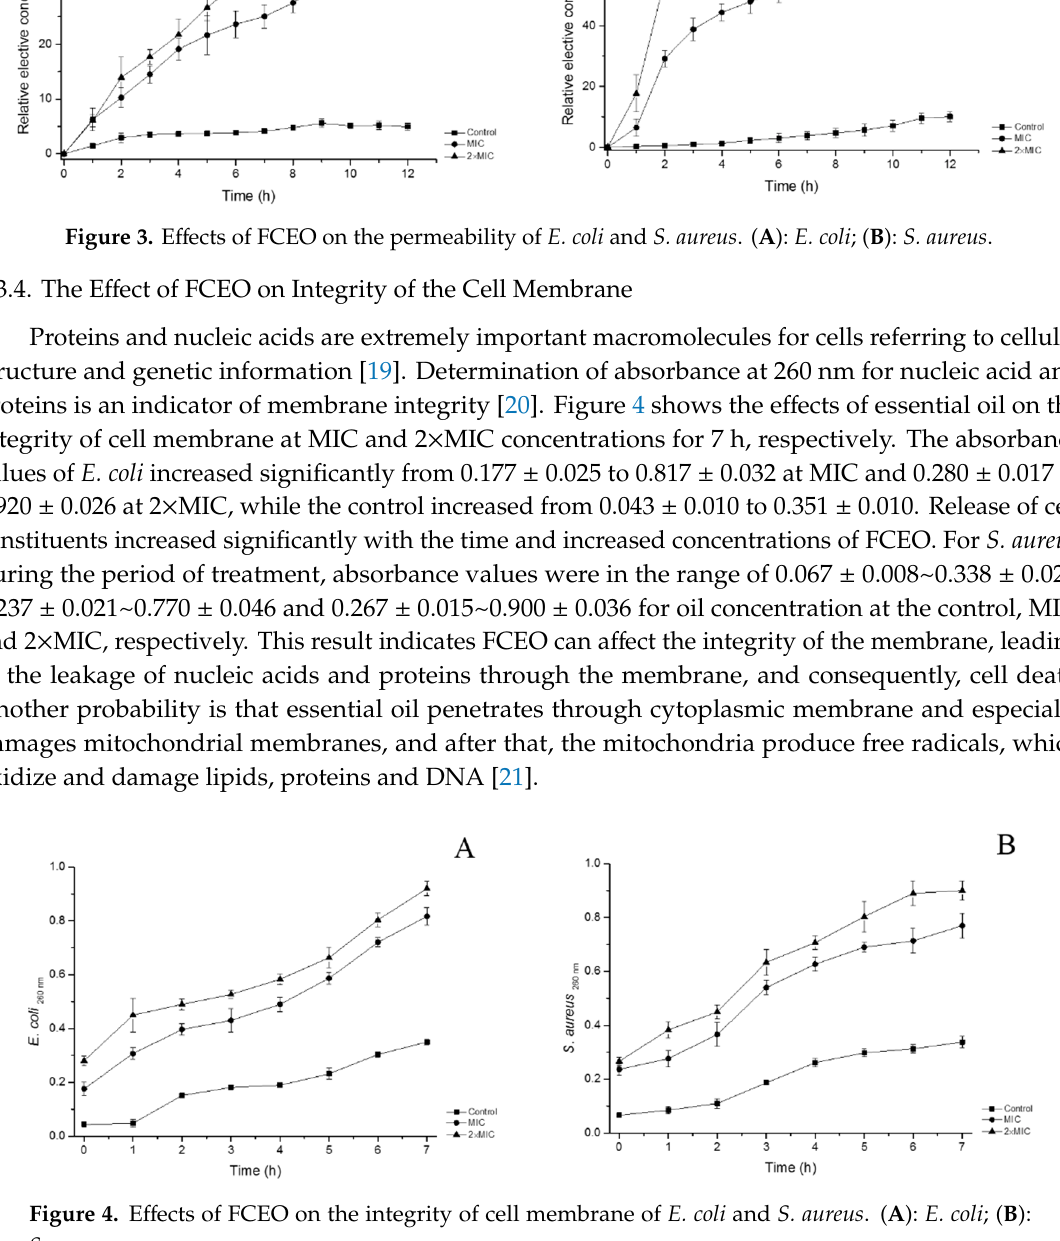
Figure 3. E ff ects of FCEO on the permeability of E. coli and S. aureus . ( A ): E. coli ; ( B ): S. aureus . Figure 3. Effects of FCEO on the permeability of E. coli and S. aureus . A : E. coli ; B : S. aureus .